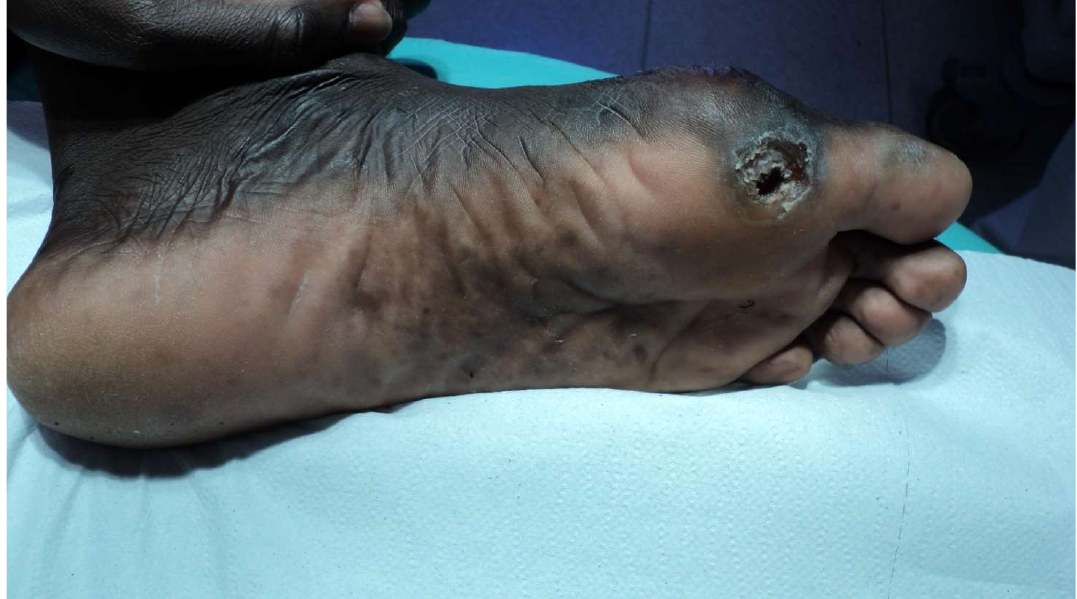
Figure 5. Plantar ulcer of the left foot caused by anesthesia of the sole resulting from damage to the posterior tibial nerve.